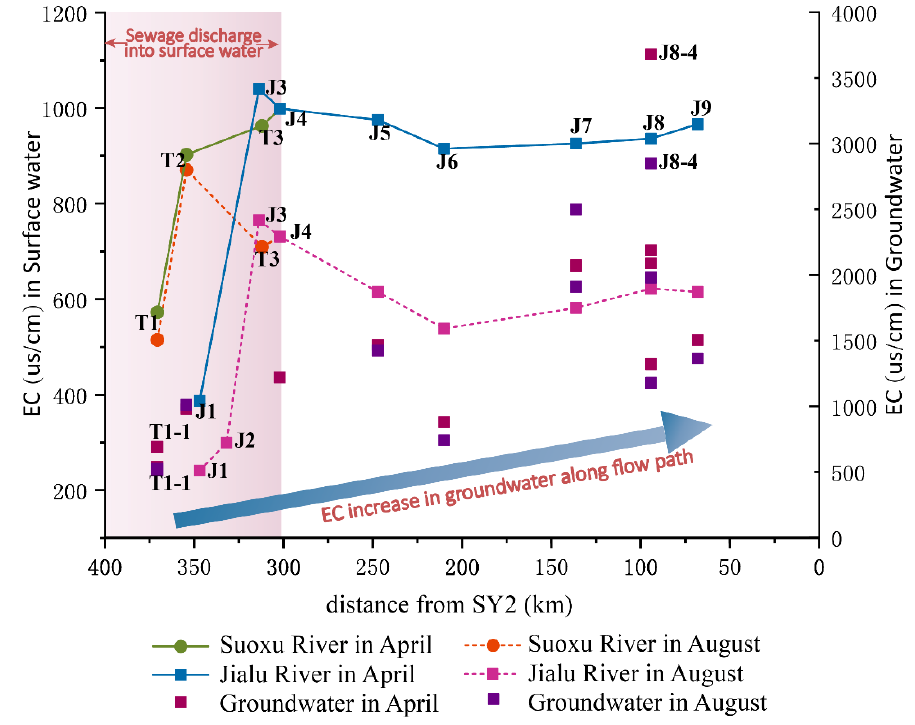
Figure 5. The distance from SY2 (Shenqiu county) profiles for electrical conductivity in the Jialu River.